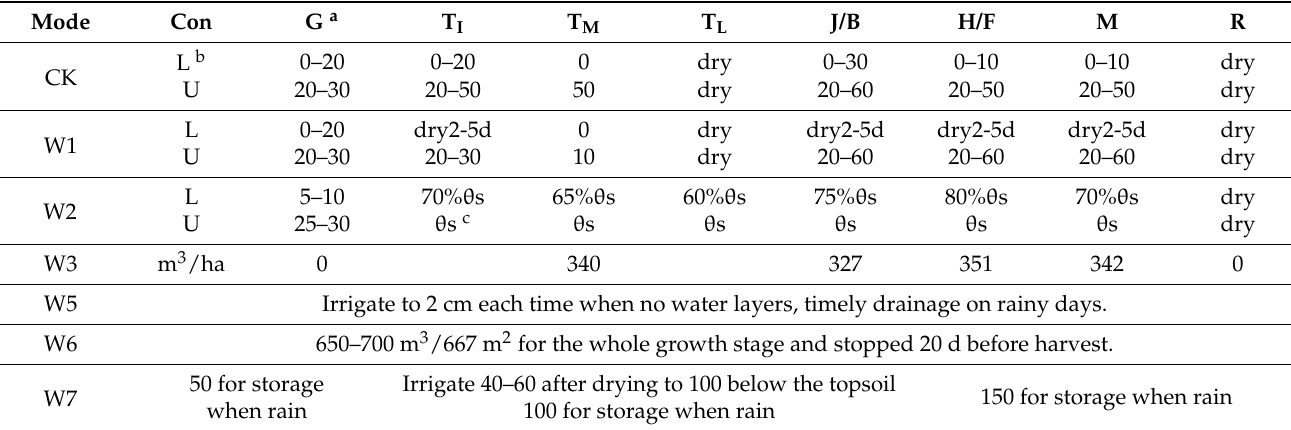
Table 2. Field moisture control standards at the growth period under different irrigation